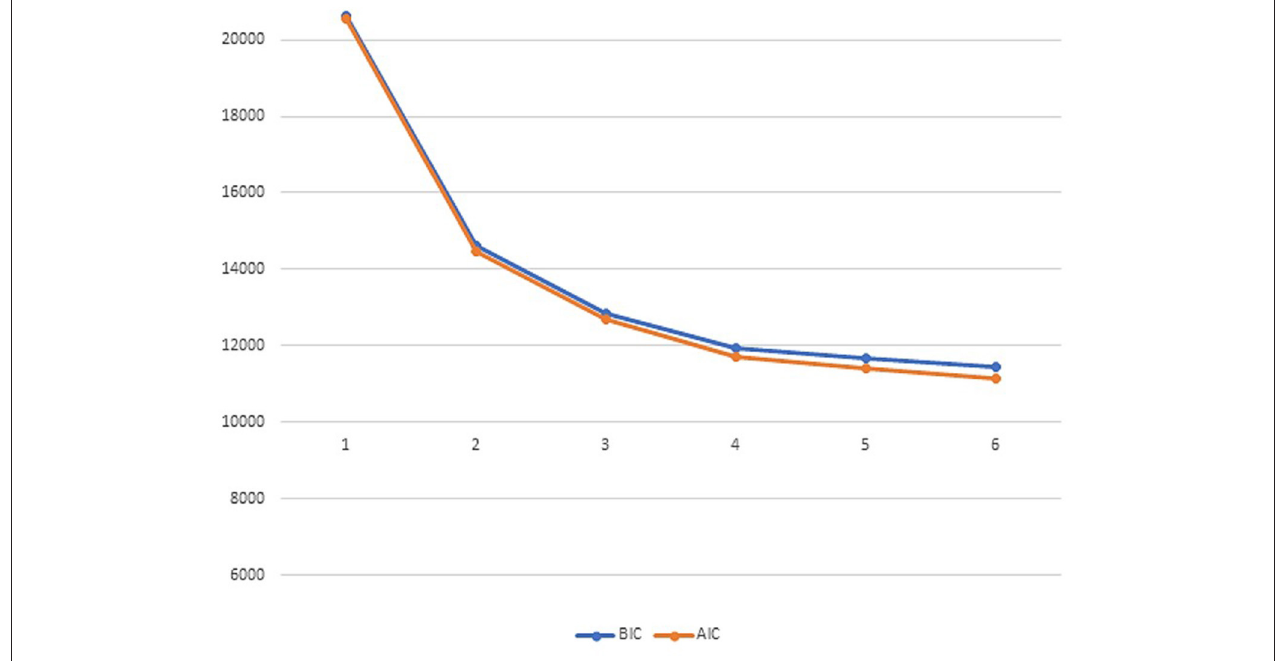
FIGURE 1 | Scree plot for AIC and BIC for six latent profiles of self-reported anxiety and depressive symptoms across a foster care, clinical, and general population youth samples. The scree plot is based on the latent profile analysis of one to six profile solutions. AIC, Akaike’s information criterion; BIC, Bayesian information